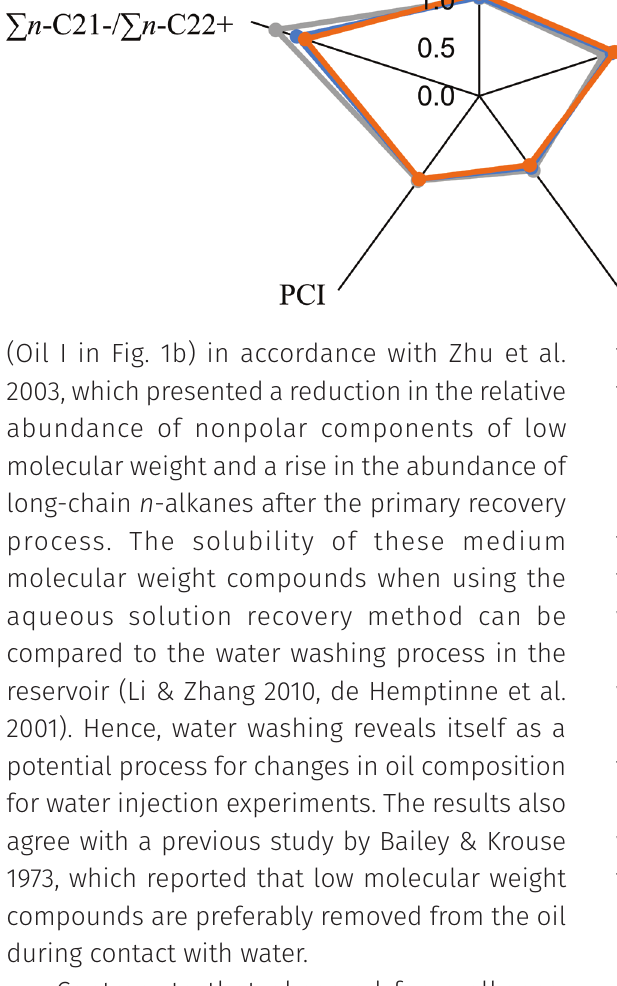
Figure 2. Star diagram of geochemical parameters obtained by the GC-FID analyses showed no significant variations, except for the Σ n -C21-/Σn- C22+